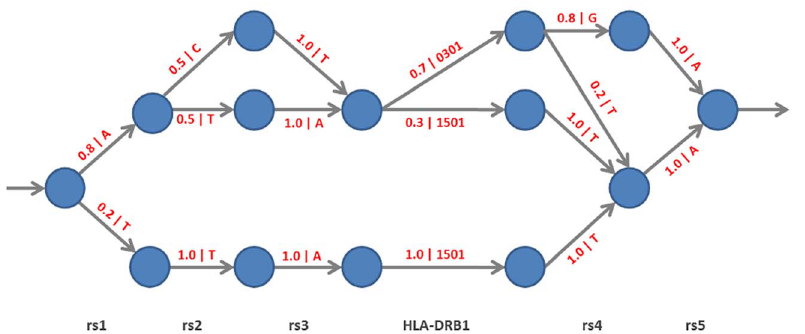
Figure 1. Features of haplotype graph models. Illustration of the features of haplotype graph models. Haplotype graphs are a subclass of connected directed graphs and belong to the class of acyclic probabilistic finite automata. Their most important properties are illustrated here: 1) They are leveled, i.e. each vertex v has an associated positive number 1, and all edges emanating from v at level l lead to a vertex at level l z 1 and represent the same genetic locus. Vertices at level T are final vertices with no outgoing edges, and there is a path from every vertex in the graph to one of the final vertices. 2) Edges carry ‘‘emission symbols’’ which are emitted when an edge is traversed (in the figure: the symbols after the ‘‘|’’ character adjacent to the edges), and there are no two edges emanating from the same vertex which carry the same symbol. 3) Each vertex has an edge probability distribution over its attached edges (in the figure: the numbers in front of the ‘‘|’’ character adjacent to the edges), according to which an edge is selected conditional in being at that